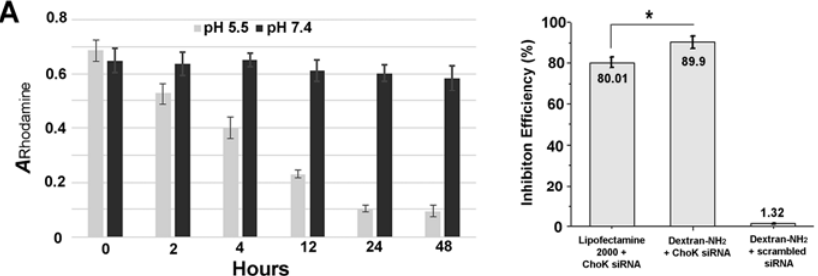
Figure 2. ( A ) The rhodamine absorbance of 1 mg/mL dextran solution in pH 5.5 and pH 7.4 buffer at different time points. n = 3, values represent Mean ± SD. ( B ) Inhibition efficiency of choline kinase (ChoK) messenger RNA (mRNA) in MDA ‐ MB ‐ 231 cells with different siRNA transfection agent treatments. Small interfering RNA (siRNA) concentration: 100 nM; N/P ratio: 15. Cells were treated with siRNA/dextran for 24 h, following by a further 6 h incubation in fresh medium. n = 3, values represent Mean ± SD. *, p < 0.05.